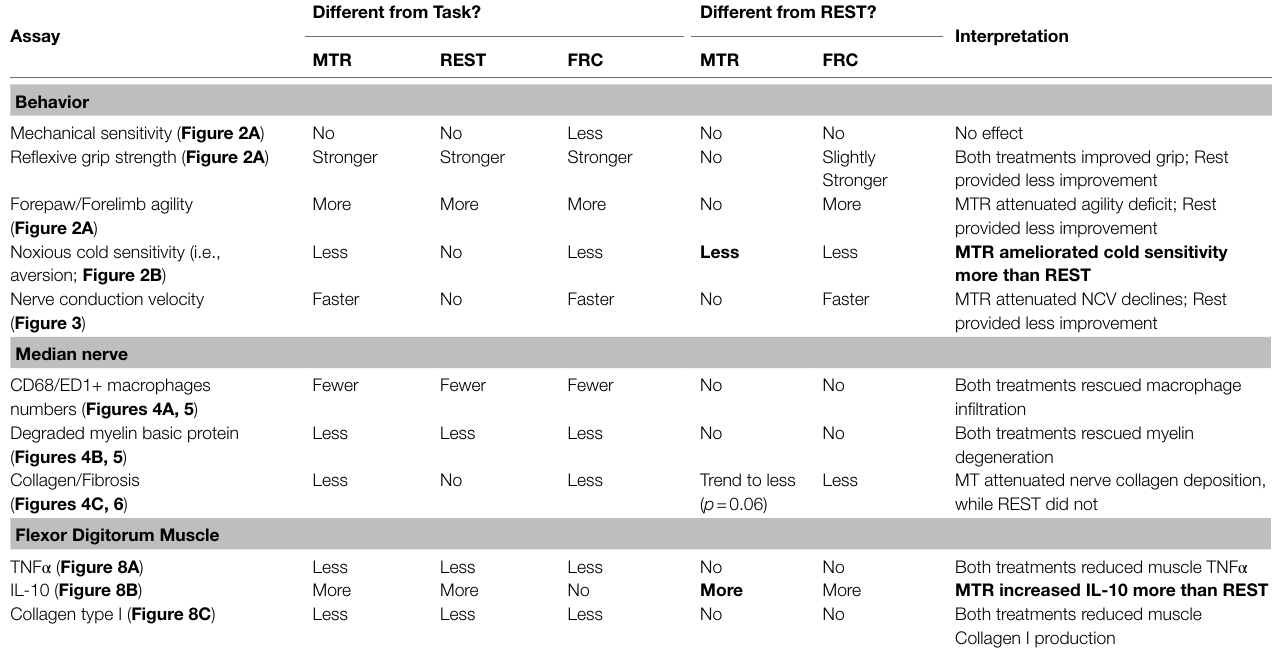
TABLE 1 | Summary of data by type and with brief interpretation.